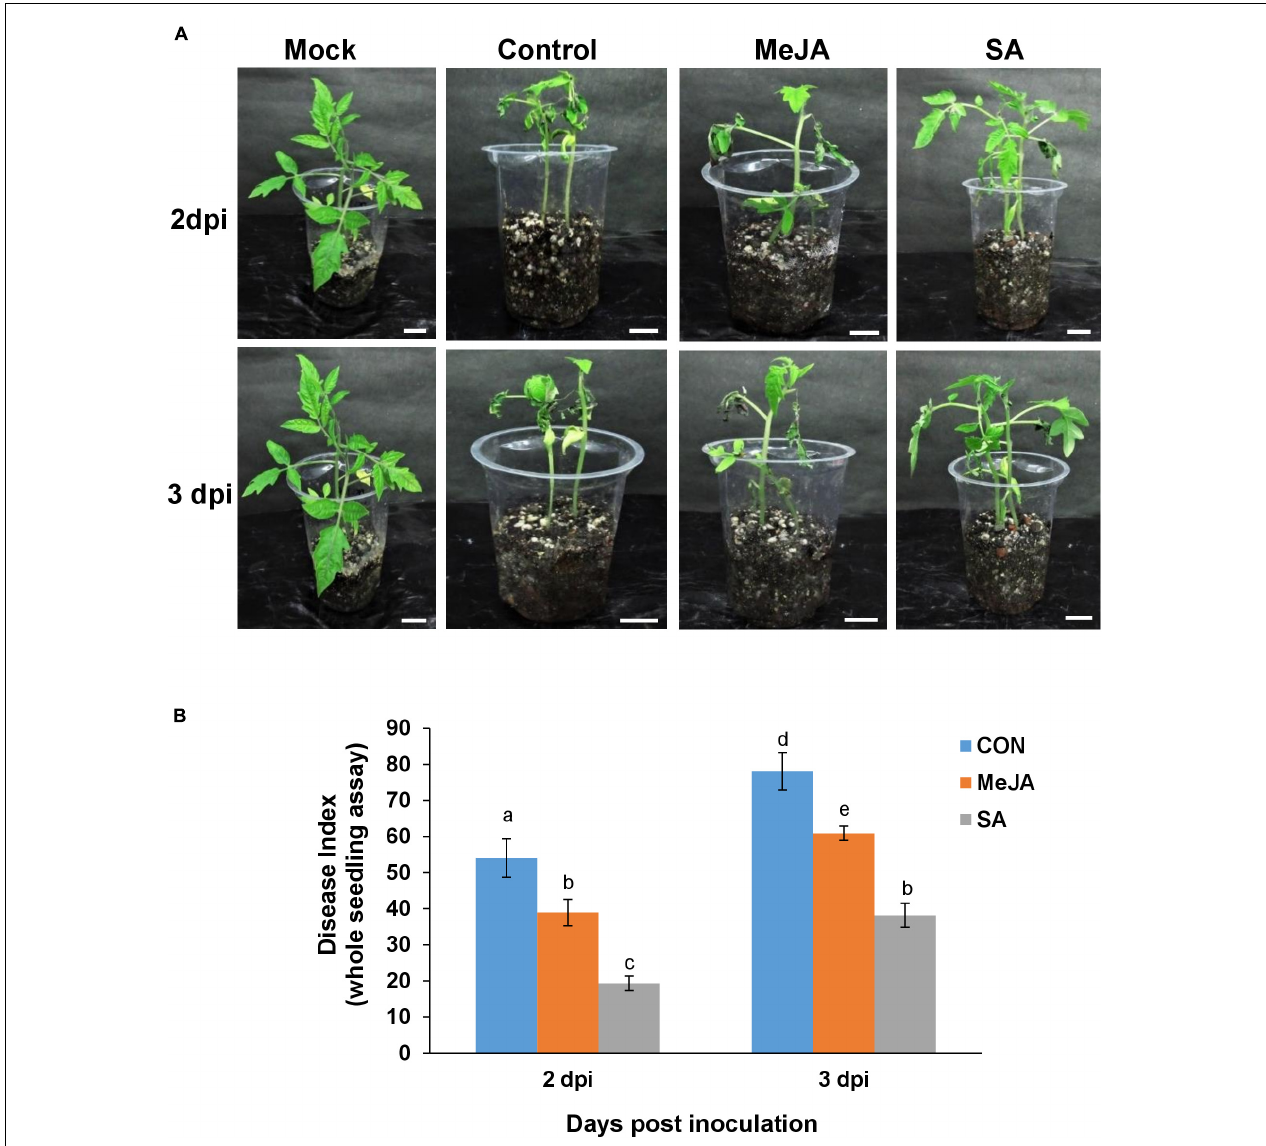
FIGURE 8 | Whole seedling assay showing disease incidence by R. solani on phytohormone primed plants compared with control. (A) MeJA pre-treated plants showed less severe symptoms than the control and but more symptoms than SA-treated ones at 2 and 3 days post-inoculation, in the order Control > MeJA > SA. (B) Comparative graphical representation of disease index in the different experimental sets at 2 and 3 dpi, calculated according to the published method. Bars represent mean ± S.E.M of four independent experiments. Different letters indicate significant differences among treatments at p < 0.05, according to Duncan’s multiple range test. Bars = 2